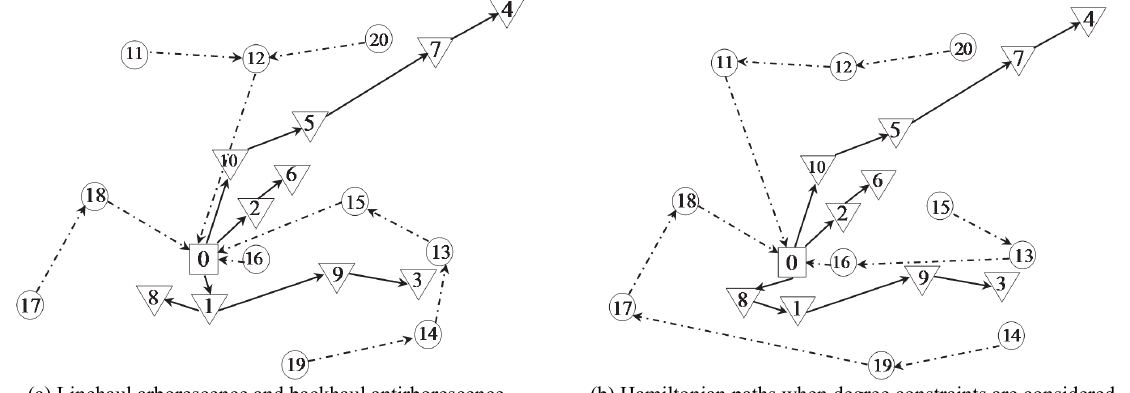
Fig. 3. Arborescence paths for 20 customers